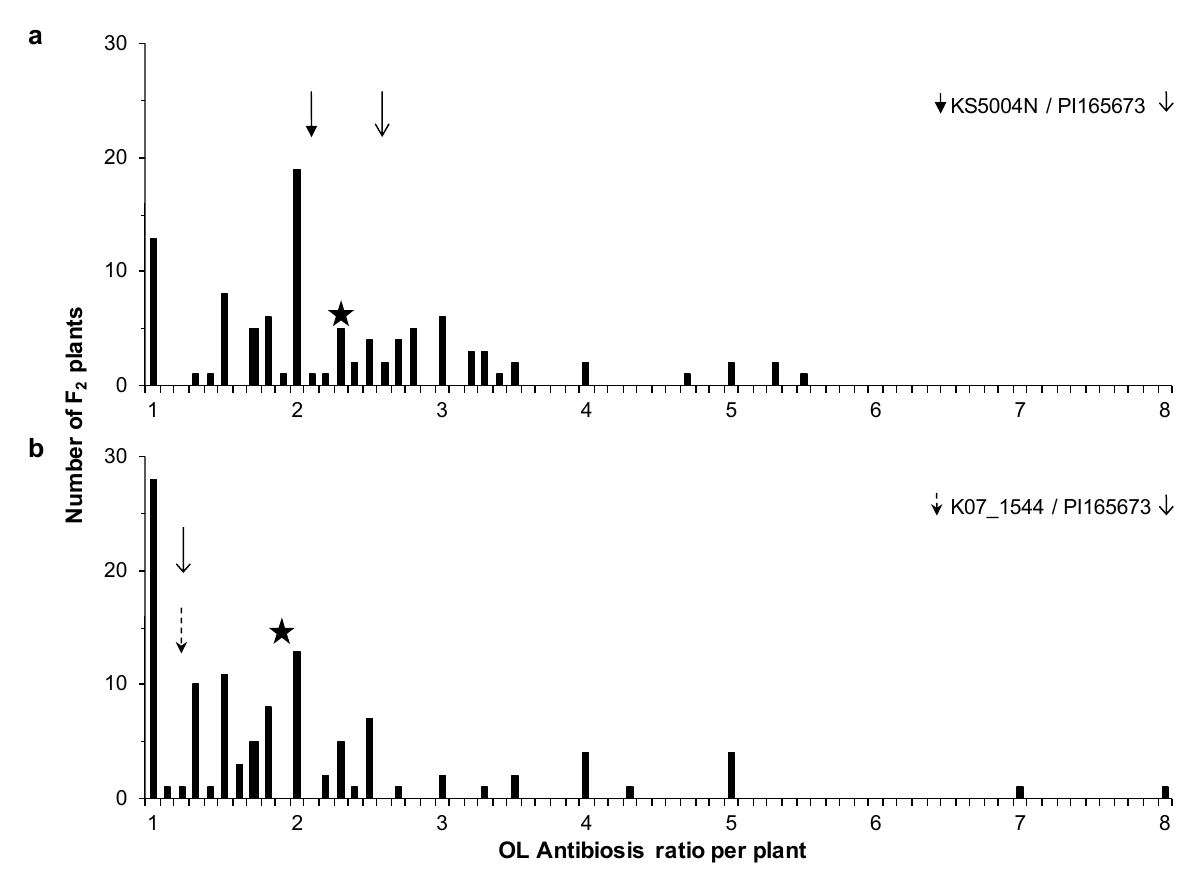
0 OL Antibiosis ratio per plant Figure 1. Frequency distributions of OL antibiosis ratios per plant in F 2 soybean populations ( a ) KS5004N/PI165673 and ( b ) K07-1544/PI165673 at 21 d post infestation with Dectes texanus in 2011. Arrows and stars indicate parent and F 2 means, respectively. OL antibiosis ratio = (number of oviposition punctures/number of larvae).